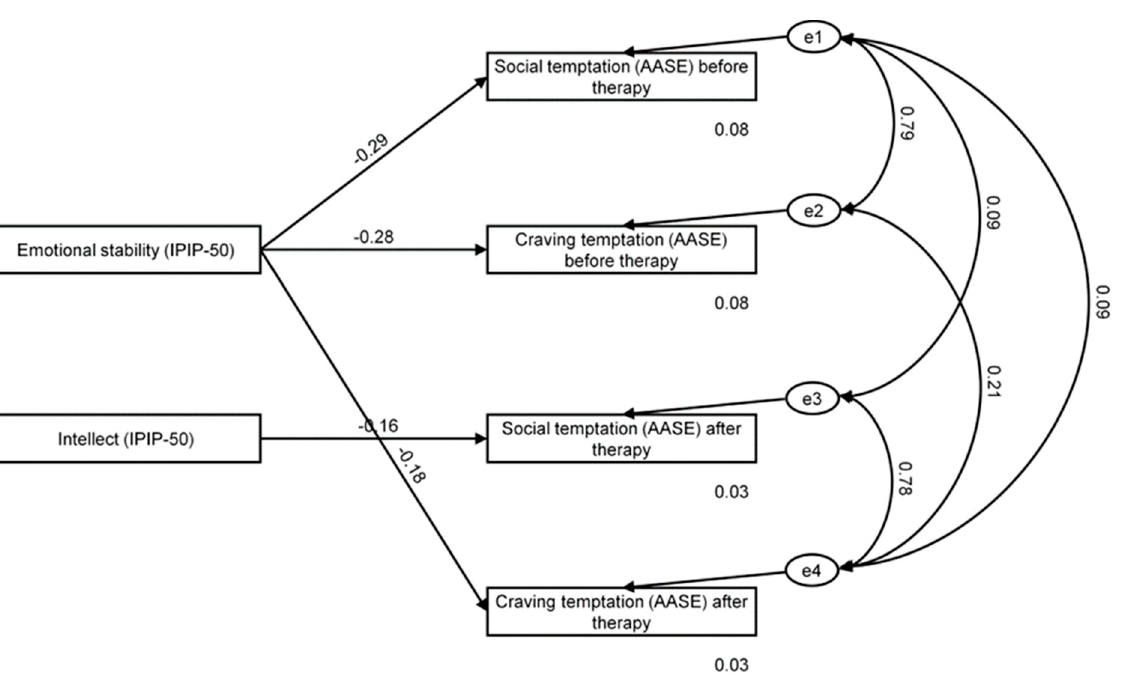
Table 5. Standardized regression weights for associations between personality and self-efficacy in the investigated group before and after therapy.